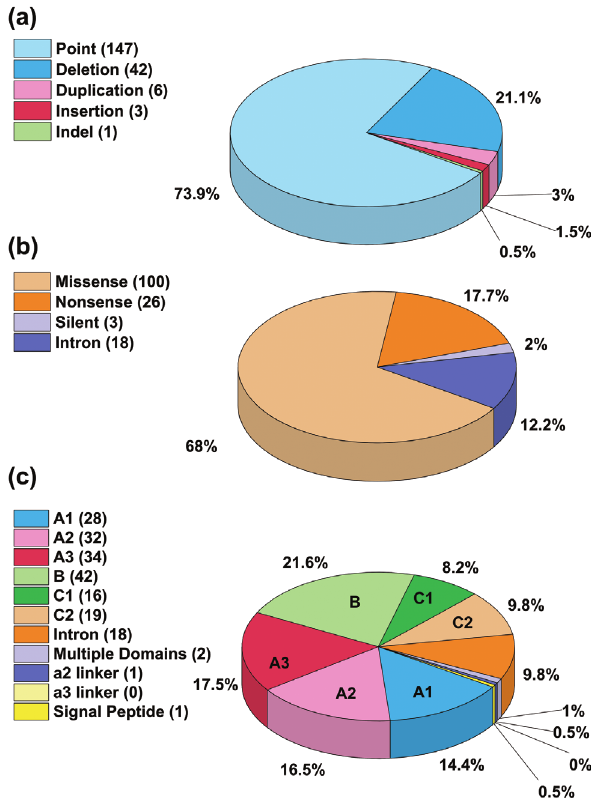
Fig. 2 Distribution of the 199 unique FV de fi ciency variants found in the F5 gene. The panels ( a – c ) indicate breakdowns of the 199 FV de fi ciency variants into variant type, effect, and location within the F5 gene sequence. ( a ) The relative frequency of six distinct types of unique variants in the F5 gene. ( b ) Effect of the 147 point variants found in the F5 gene sequence. ( c ) Distribution of the 199 FV variants across the F5 gene and FV protein domains, although six unde fi ned or not applicable variants are not shown. FV, Factor